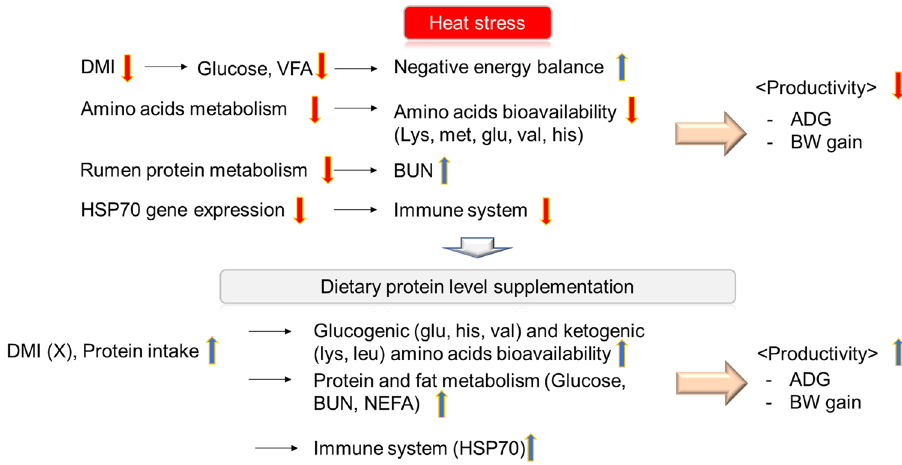
Figure 5. Effects of dietary protein levels on productivity in Korean native beef